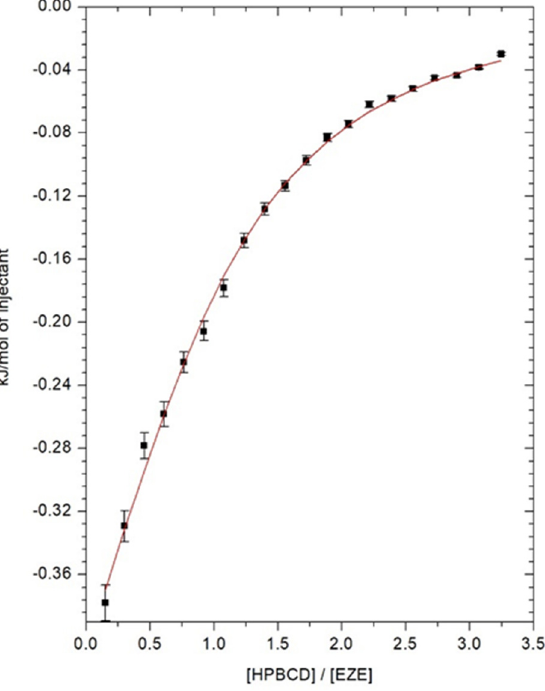
Figure 4. Direct effects of interaction between 0.5 mM ezetimibe and 8.52 mM HP- β -cyclodextrin.